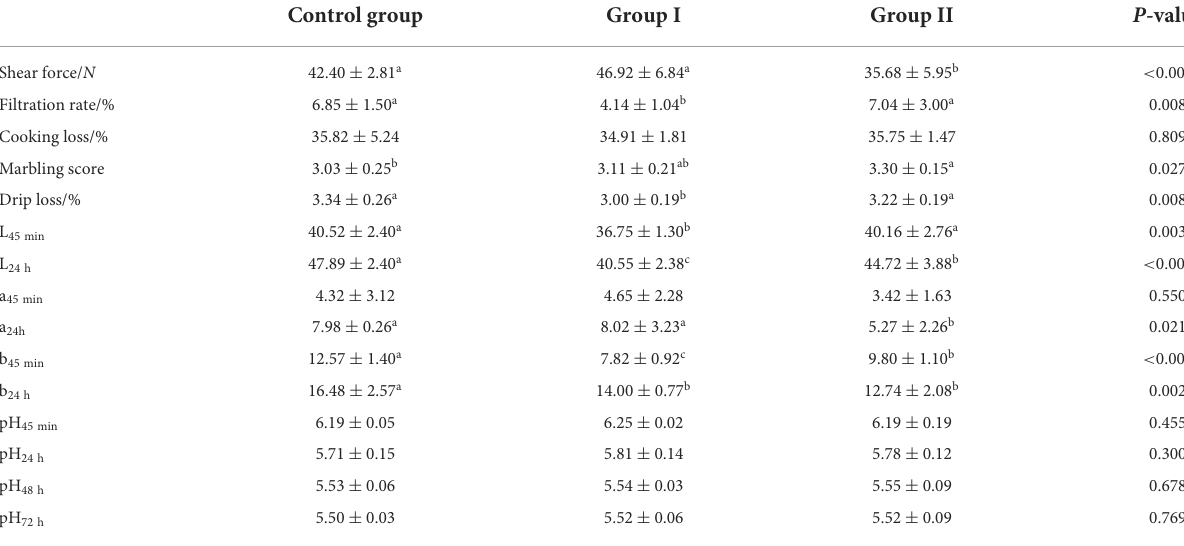
TABLE 5 Effect of dietary protein level on routine indexes of meat quality in finishing pigs.